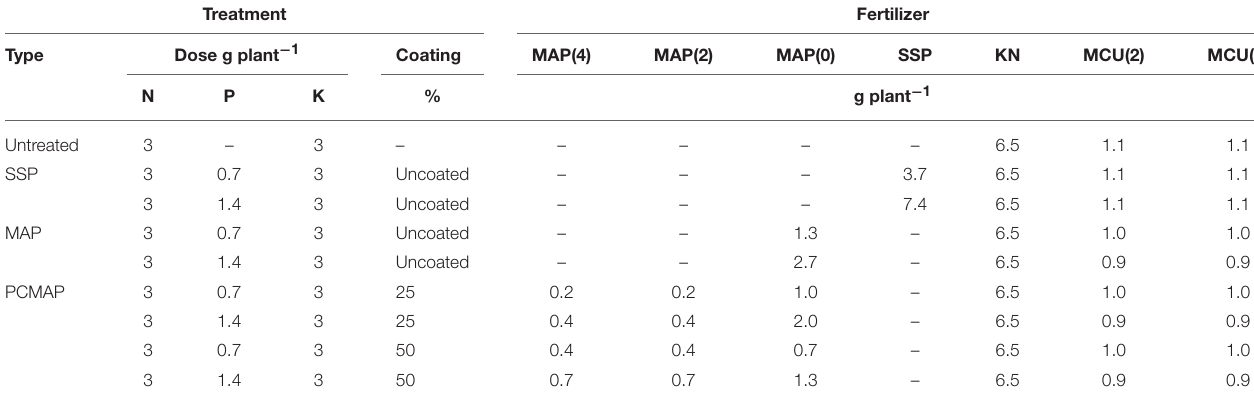
TABLE 1 | Experimental treatments: type, dose, coating, and formulations.